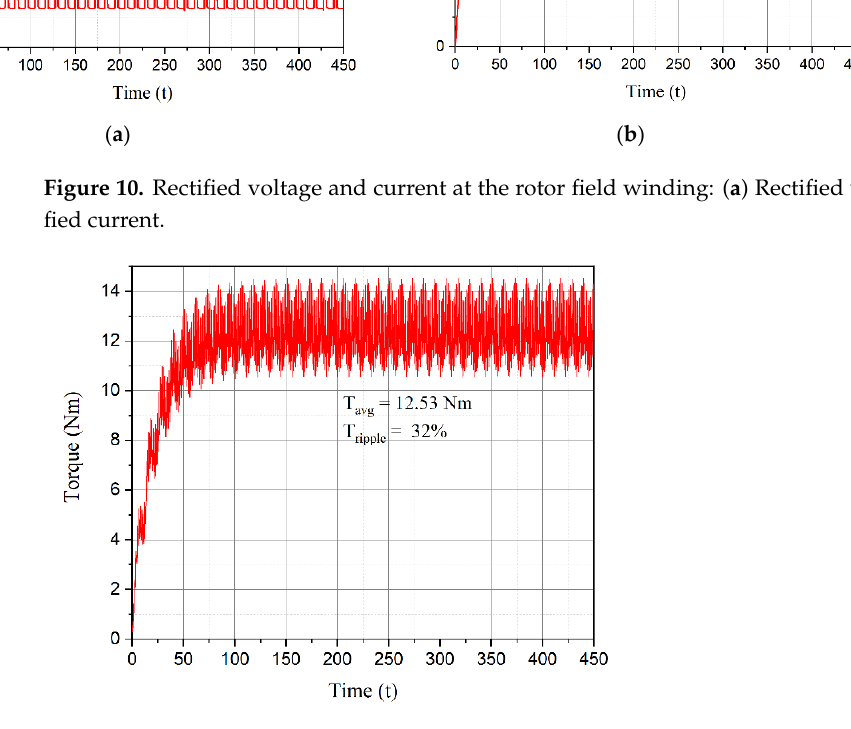
Table 3. Variation in performance of proposed SHSM with different conductors of XYZ winding.